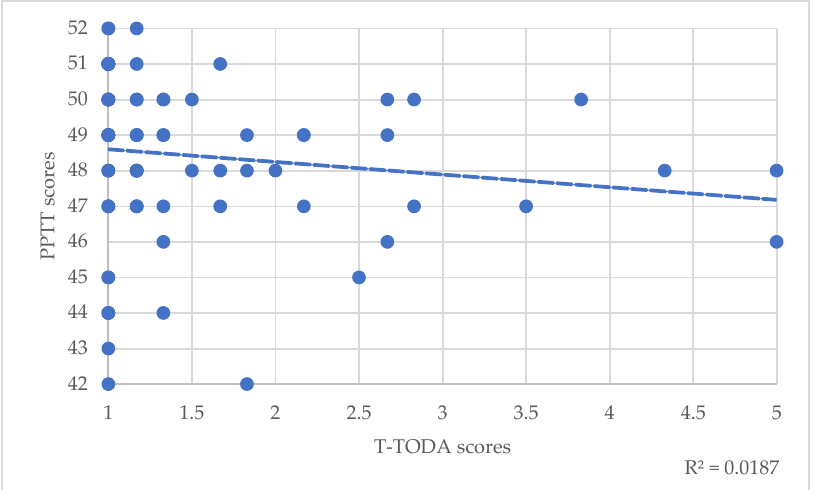
Brain Sci. 2022 , 12 , x FOR PEER REVIEW Figure 1. Correlations between PPTT scores and T-TODA scores. The dotted line represents the trend line.